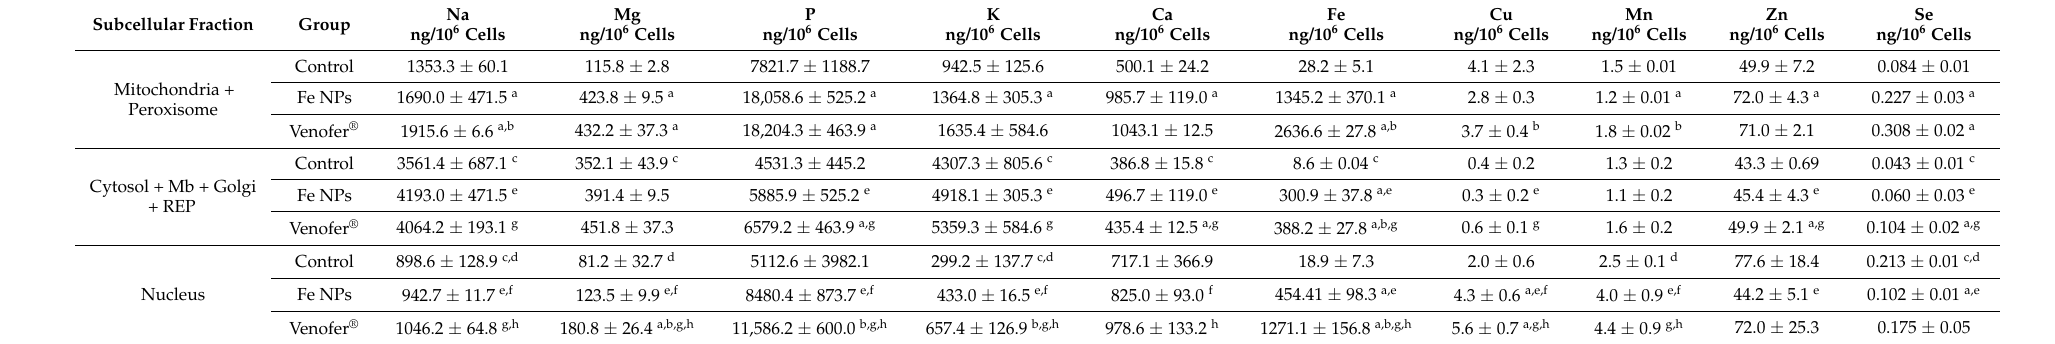
Table 1. Metal concentrations in HT-29 subcellular